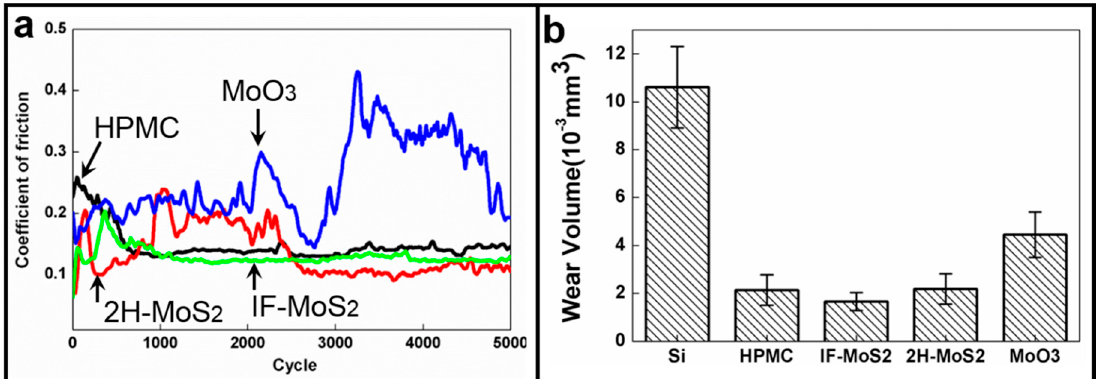
Figure 7. ( a ) COF results of pure HPMC and IF-MoS 2 NP-, 2H-MoS 2 NP-, and MoO 3 NP-added HPMC; ( b ) wear volume of Si, pure HPMC, and IF-MoS 2 -, 2H-MoS 2 -, and MoO 3 -added HPMC.